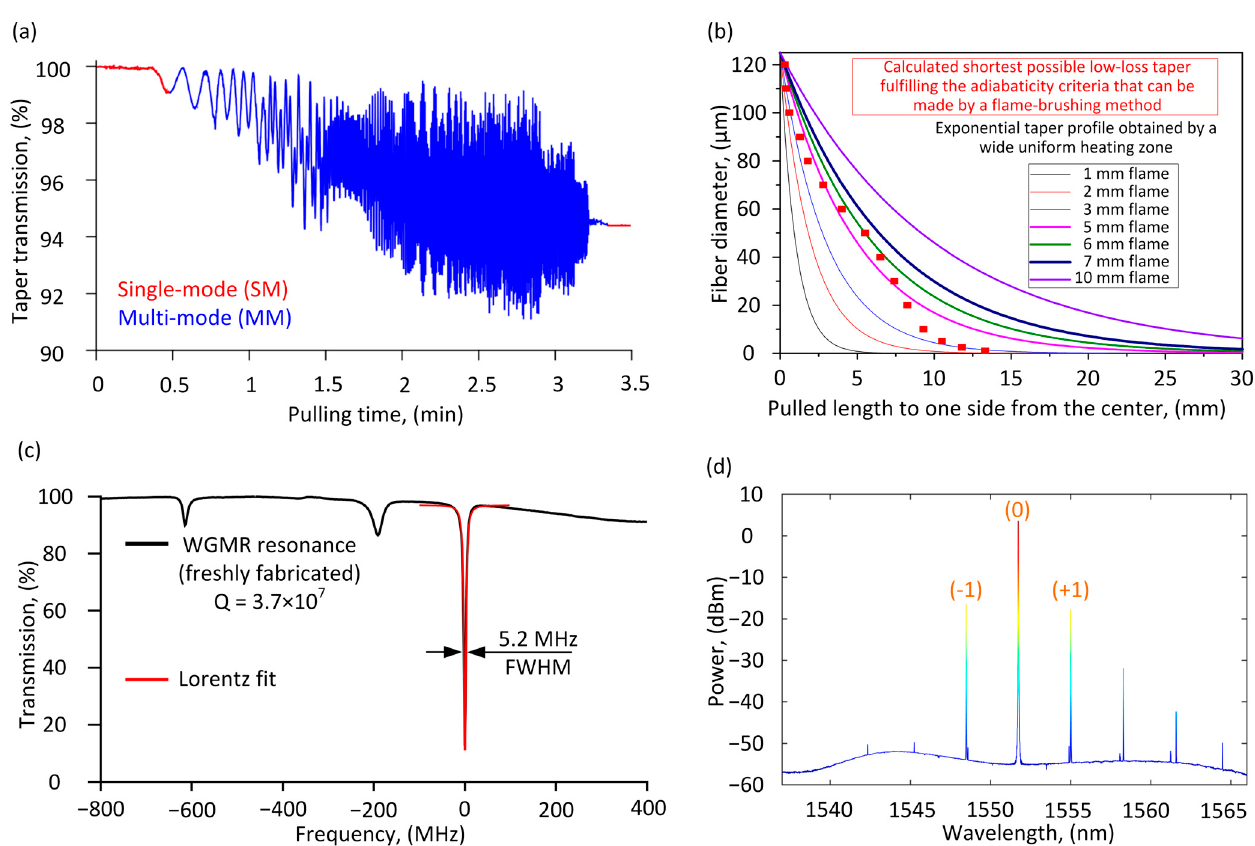
Figure 3. Experimental setup used for the characterization of the tapered fiber and silica micro- sphere.